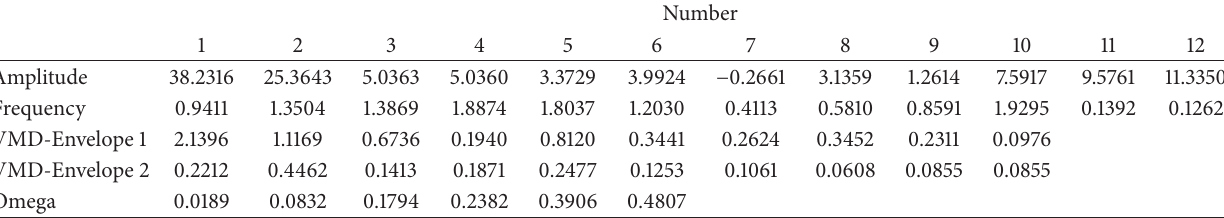
Table 3: An example of feature parameters.